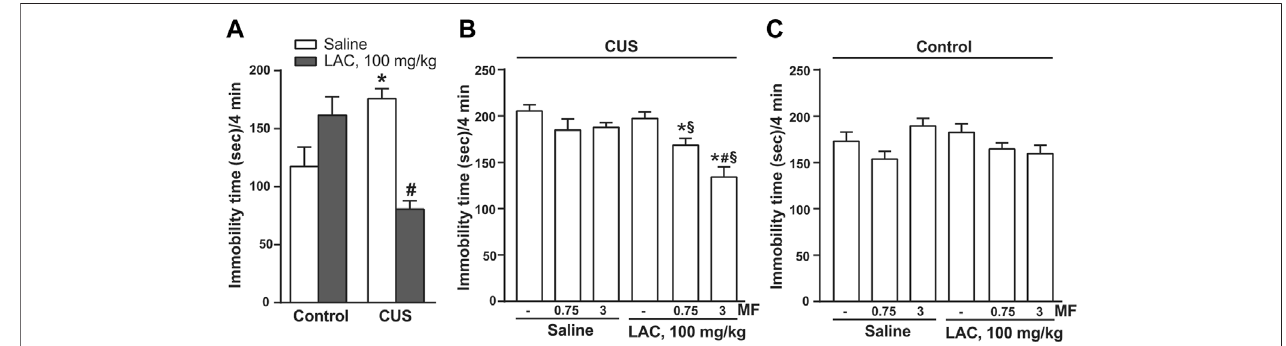
FIGURE1| SynergismbetweenMF and “ anti-depressive doses ” ofLACinreducingtheimmobilitytime inmice subjected toCUS. In (A) , eitherunstressed (Ctrl) or CUSmiceweretreatedi.p.withLAC(100 mg/kg)orsalinefor9 days.In (B) or (C) ,CUS (B) orCtrl (C) miceweretreatedfor3 dayswitheithersalineorLAC(100 mg/kg) combinedornotwithMF(0.75 or3 mg/kg, i.p.).Dataaremeans±SEM.One-wayANOVA+Fisher ’ sLSD. (A) * p < 0.05vs.Ctrlsaline; # p < 0.05vs.CUSsalineand Ctrl LAC100 mg/kg;F (3,26) =11.09( n =7 – 8). (B) * p < 0.05vs.salineandLACalone;# p < 0.05vs.LAC+MF0.75,vs.MF3 mg/kg,andvs.MF0.75;F (5,41) =9.542( n = 8). Neither LAC nor MF alone or in combination caused changes in the immobility time in unstressed mice after 3 days of treatment (C) ( n =